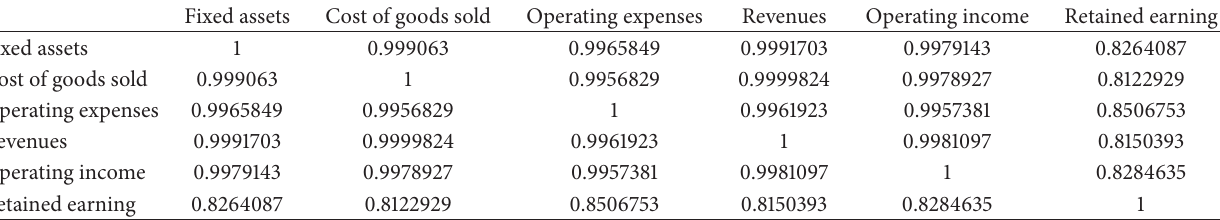
Table 10: Correlation of input and output data in